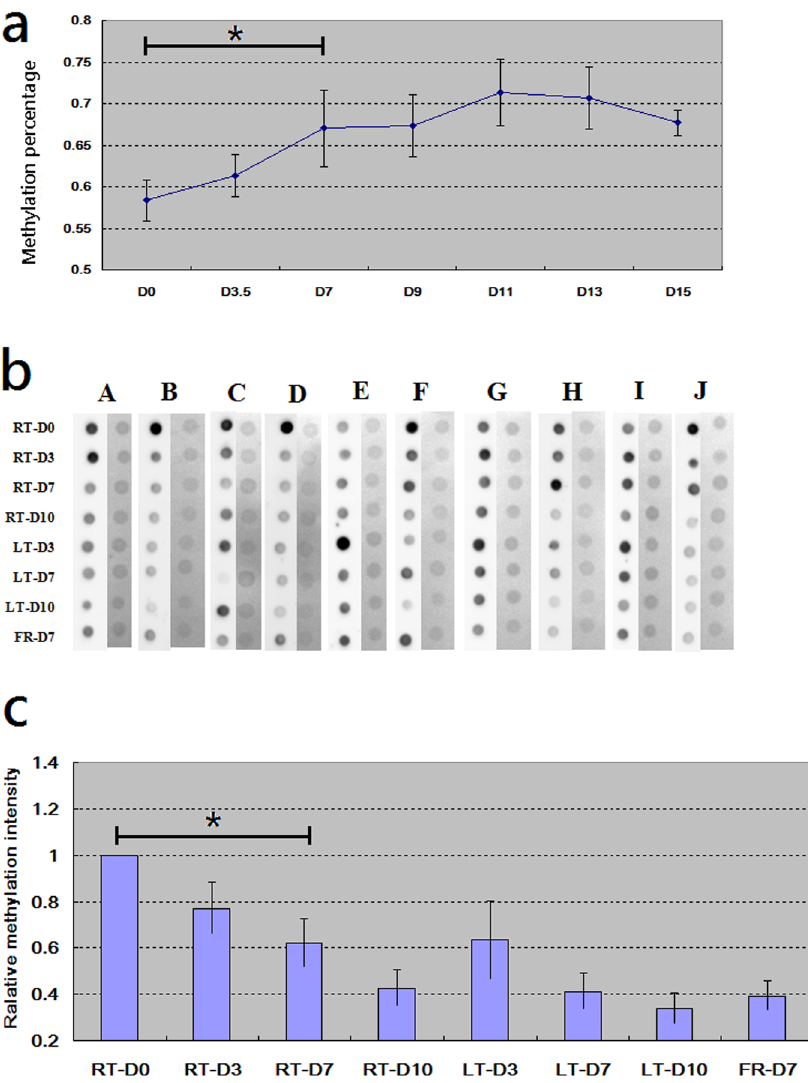
Fig 4. Examinations on DNA methylation. We investigated whether the variationon DNA methylationcould be observedowingto different storagetemperature and storageduration. * denotedsignificance by t-test. (a) CpG marker cg08298591 is located at CCL22.We determinedits methylationpercentage on samples.All bloodsampleswere collectedfrom one singlesubject andstored at 24˚C. For each durationpoint, three blood sampleswerecollected(N = 3). Comparedwith fresh condition(D0), cg08298591 was differentially methylated at the durationpoint D7 ( P < 0.05).Data was presented as mean ± SD.(b) We conducted dot blot assay to evaluateglobalDNA methylation. DNA samplesfrom ten subjects(A, B, C andso on) werecollected(N = 10), formingdifferent combinations of temperatureand duration.For the samples from each subject, the left column denotedthe methylationintensitiesof differentsamplesand the right columndenotedthe corresponding loadingcontrol. (c) The methylationintensitiesin Fig 4B were normalizedbasedon the correspondingloading controlsand plotted. Data was presentedas mean ± SEM. With longerduration,no matter at room or low temperature, globalmethylationintensitiesdecreased. four genes had significantly different (p < 0.05) Ct values by heparin or EDTA. So, heparin did not contaminate the RNA samples from WBC and did not interfere with PCR reaction accord-